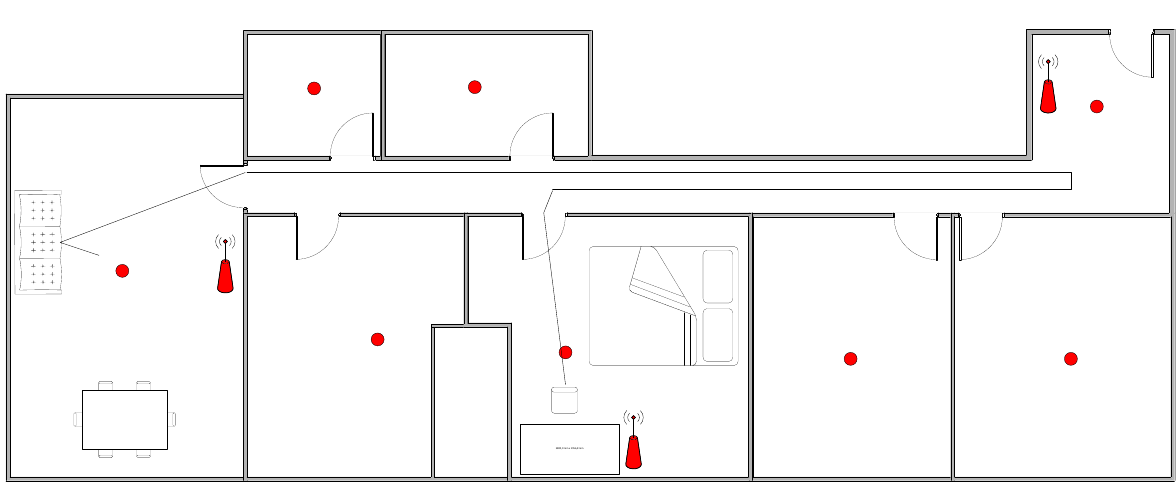
Figure 10. Path followed in the